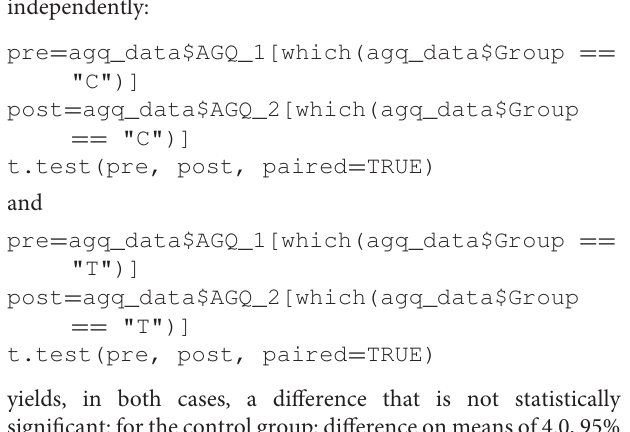
Which yields "AGQ Pre = 46.2 + /- 7.6" "AGQ Post = 43.6 + /-